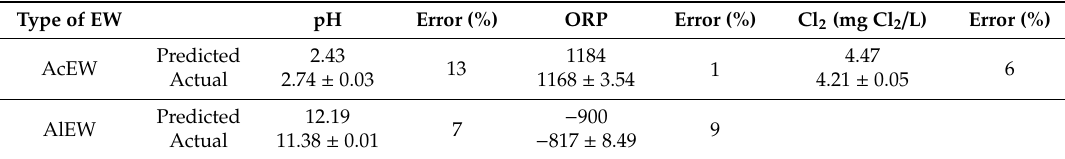
Table 13. Experimental validation of pH, ORP and free chlorine using stainless steel as cathode for AcEW and